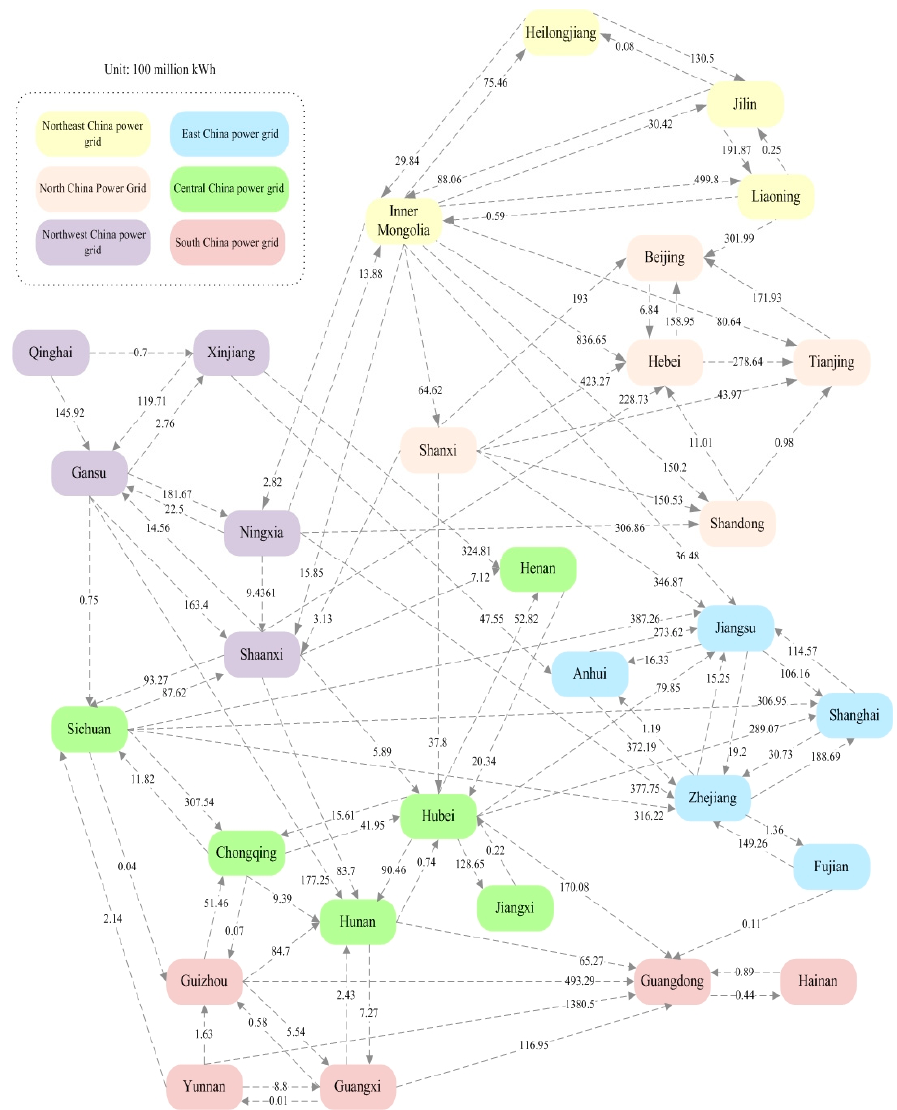
Figure 1. Inter-provincial electricity trade in China, 2017.